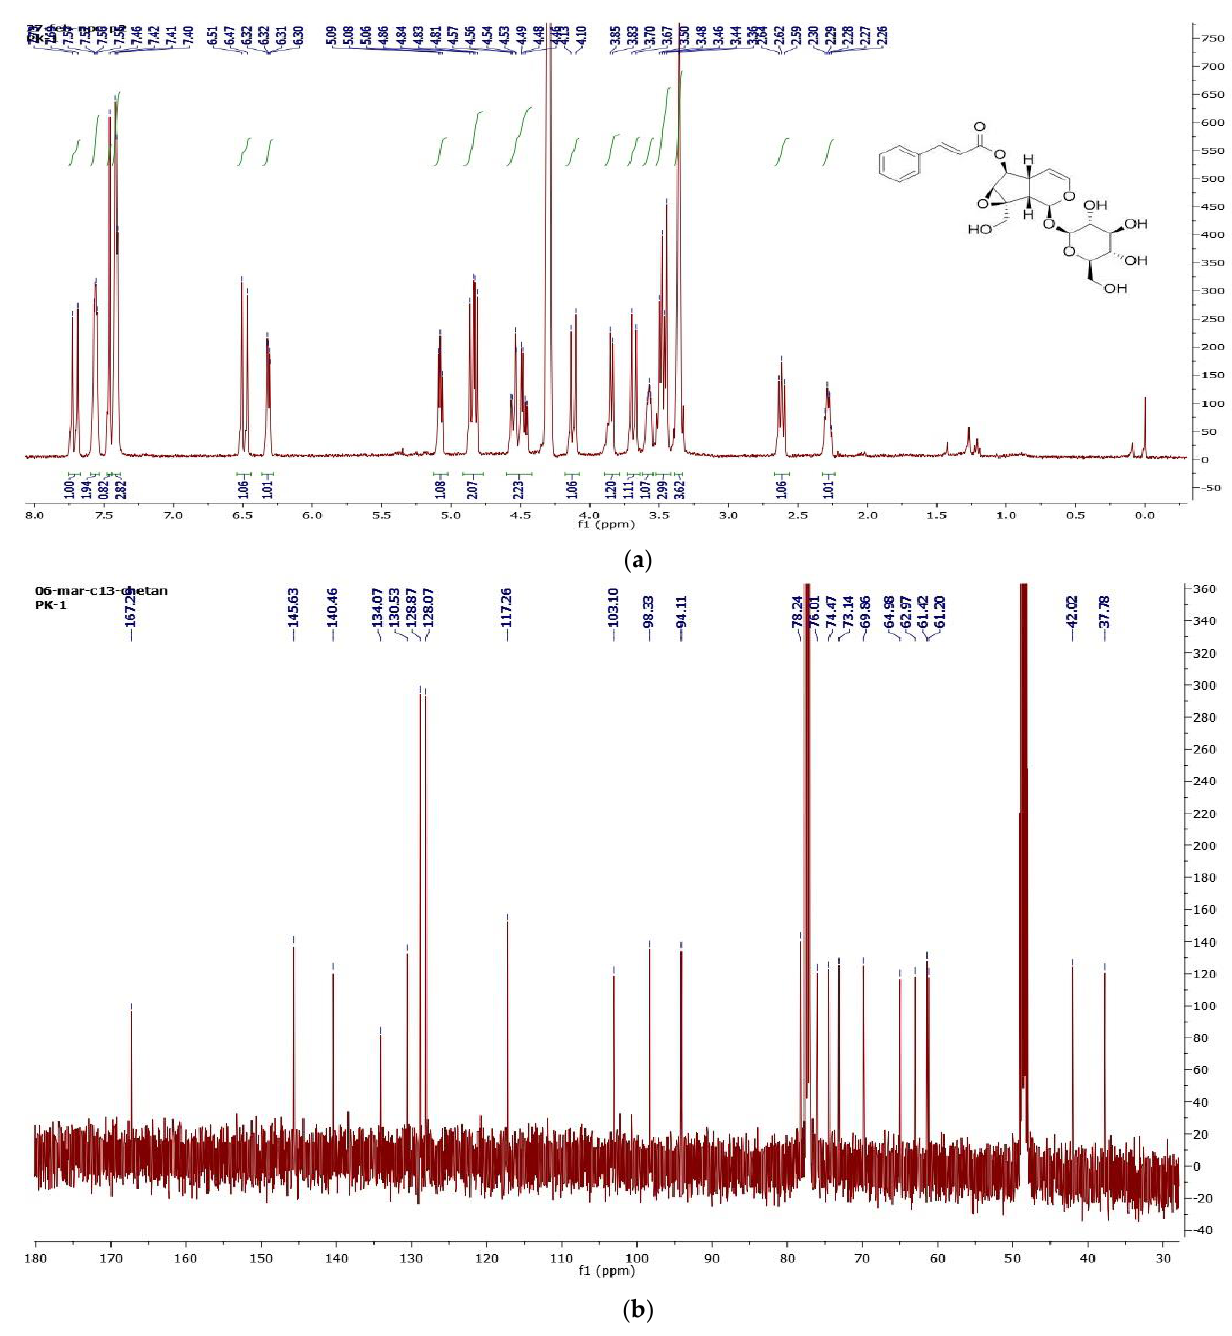
Figure 3. ( a ) The 1 H NMR and ( b ) 13 C NMR spectra of picroside – 1.